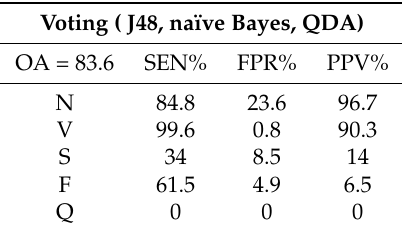
Table 11. Performance measures for combining J48, naïve Bayes, and QDA classifiers using a Voting scheme.